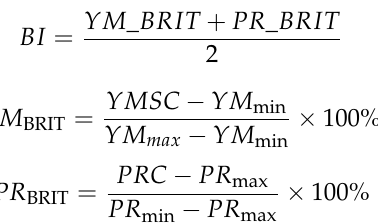
Figure 9. Cross-section map of Poisson ratio in the N–S direction. Figure 10. Cross-section map of the brittleness index in the N–S direction. Based on the geomechanical modeling results, the geomechanical parameters were calibrated by history matching of an existing well fracturing operation with the produc- tion history so as to ensure the precision of the simulation model. Figure 11 shows the production history matching result, which is in agreement with the actual field operations. Figure 12 shows the spatial fracture distribution in each payzone, which indicates that the